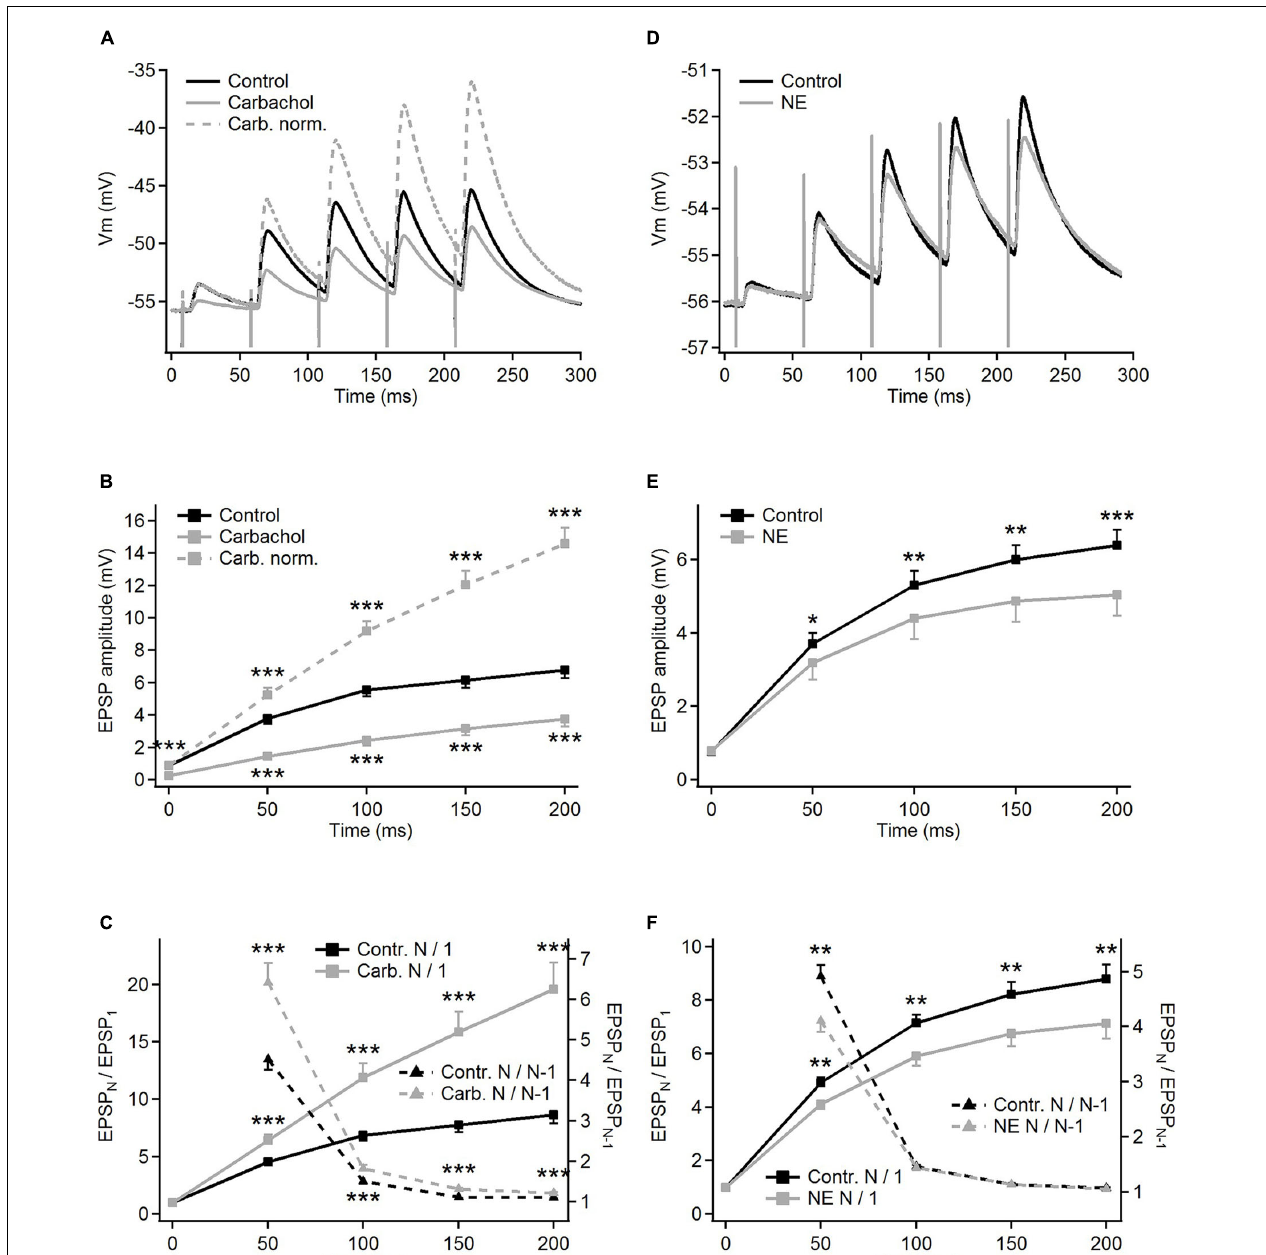
FIGURE 2 | Modulation of frequency-dependent facilitation of the cortico-thalamic synapse in PoM by cholinergic and noradrenergic agents. (A) Examples of facilitating synaptic responses of a single PoM cell to the electrical stimulation of the cortico-thalamic axons in control condition with ACSF containing GABA inhibitors (black trace, average of 11 trials), and after adding 6–8 µ M carbachol (solid gray trace, average of 33 trials). Dashed gray trace shows the data with carbachol after normalization to the first control EPSP. (B) Average amplitudes of the consecutive EPSPs in the train, measured for a group of 16 cells studied with carbachol. Mean amplitudes obtained for “carbachol” (solid gray line) conditions were significantly lower than in “control” (black line) for each EPSP in the train. (C) Left Y axis: normalized amplitudes (EPSP N /EPSP 1 , the same n = 16 cells) in control conditions (solid black trace) and in the presence of carbachol [solid gray line; note that the same data are included in (B) as gray dashed line]. Right Y axis: momentary facilitation, i.e., ratios of the consecutive EPSP amplitudes (EPSP N /EPSP N − 1 ) in control conditions and after application of carbachol (dashed lines). Both measures were significantly different from control values for all EPSP in the train. (D) Examples of the averages of single cell postsynaptic responses to stimulation of the corticothalamic axons in the control condition with GABA inhibitors and ascorbic acid (black trace, 22 repetitions) and after adding 100 µ M norepinephrine (NE, gray trace, 32 repetitions). (E) Average amplitudes of the consecutive EPSPs measured for a whole group of cells ( n = 15) studied with norepinephrine. Black trace shows EPSP amplitudes in control condition, gray trace – after adding norepinephrine. (F) Left Y axis: average normalized EPSP amplitudes (EPSP N /EPSP 1 ) in the control condition (black trace) and after application of norepinephrine (gray trace). Right Y axis: average ratios of the neighboring EPSP amplitudes (EPSP N /EPSP N − 1 ) in the control condition and after application of norepinephrine (black and gray dashed lines, respectively). Data are expressed as mean ± SEM, * P ≤ 0.05, ** P ≤ 0.01, *** P ≤ 0.001.